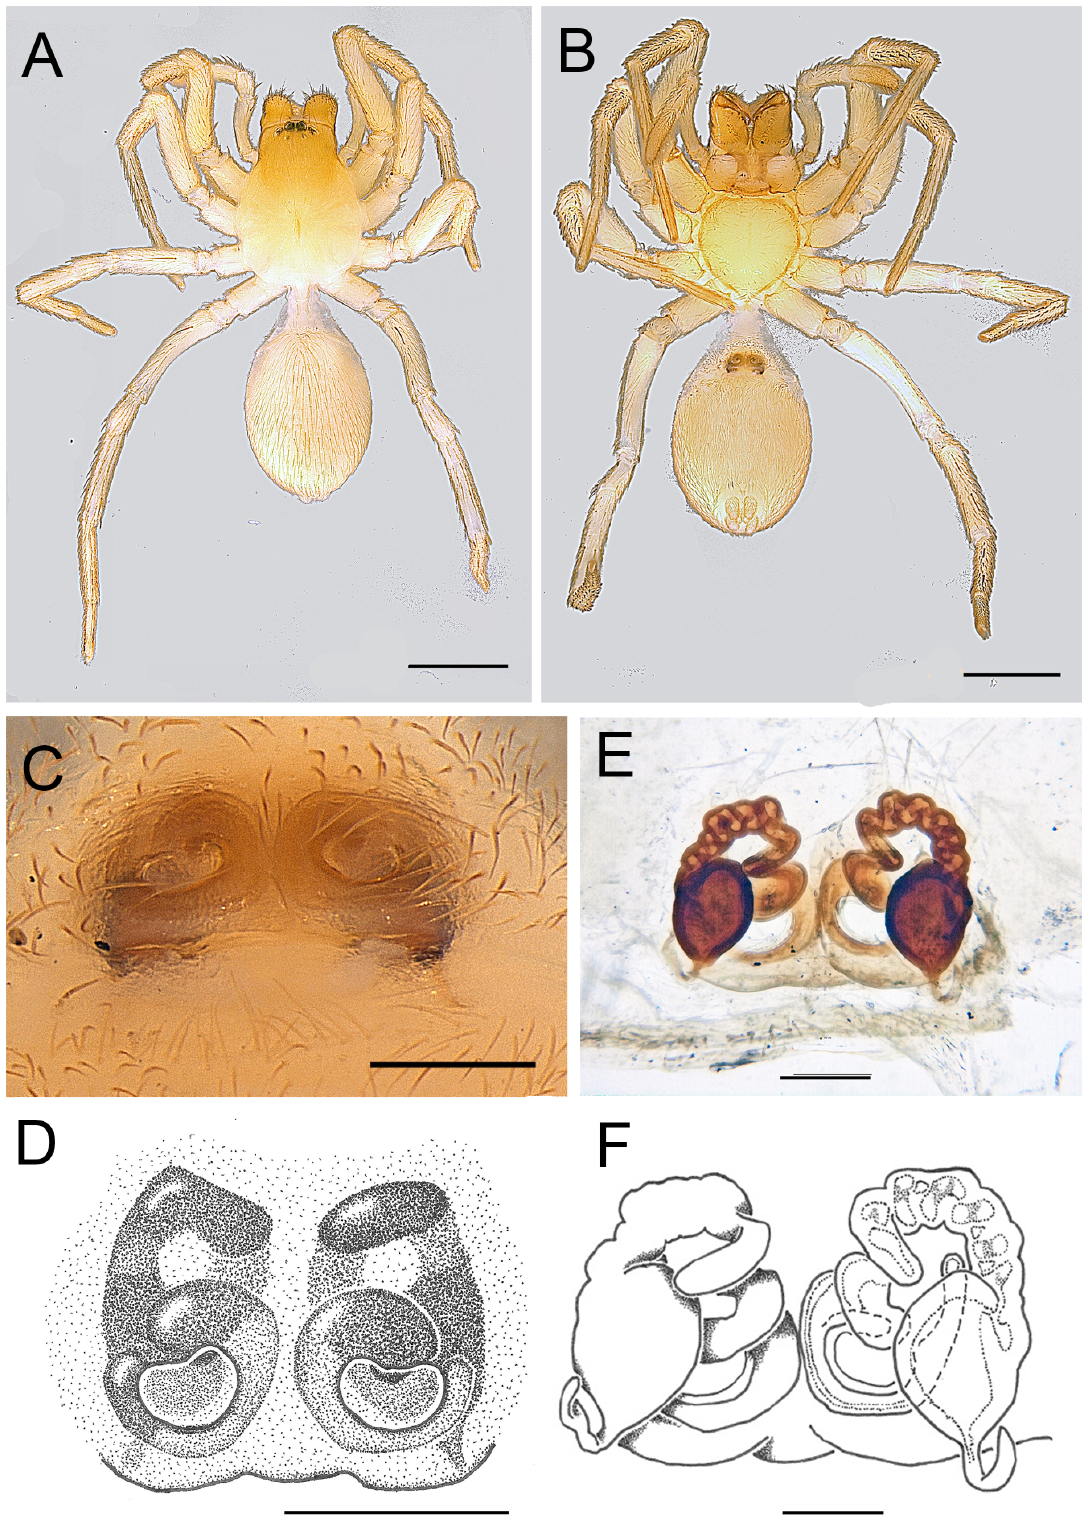
Fig. 14. Andromma cycnotrachelos sp. nov., ♀, paratype (BE_RMCA_ARA.Ara 144678). A . Habitus, dorsal view. B . Same, ventral view. C–D . Epigyne, ventral view. E–F . Same, cleared, dorsal view. Scale bars: A–B = 1 mm; C–D = 0.2 mm; E–F = 0.1